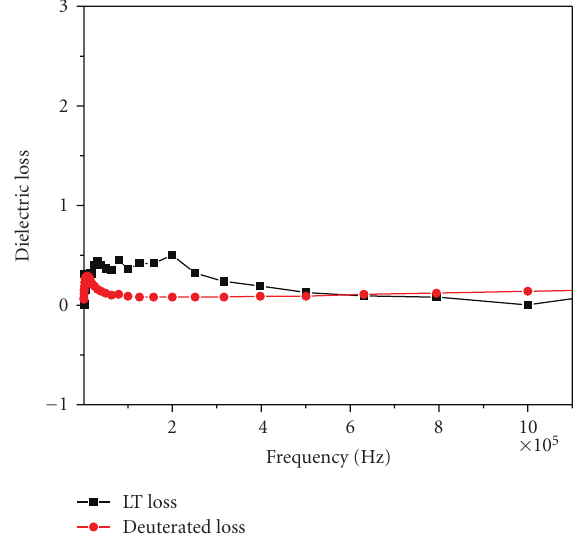
Figure 34: Dielectric loss of pure and deuterated L-threonine single crystal at various frequencies.